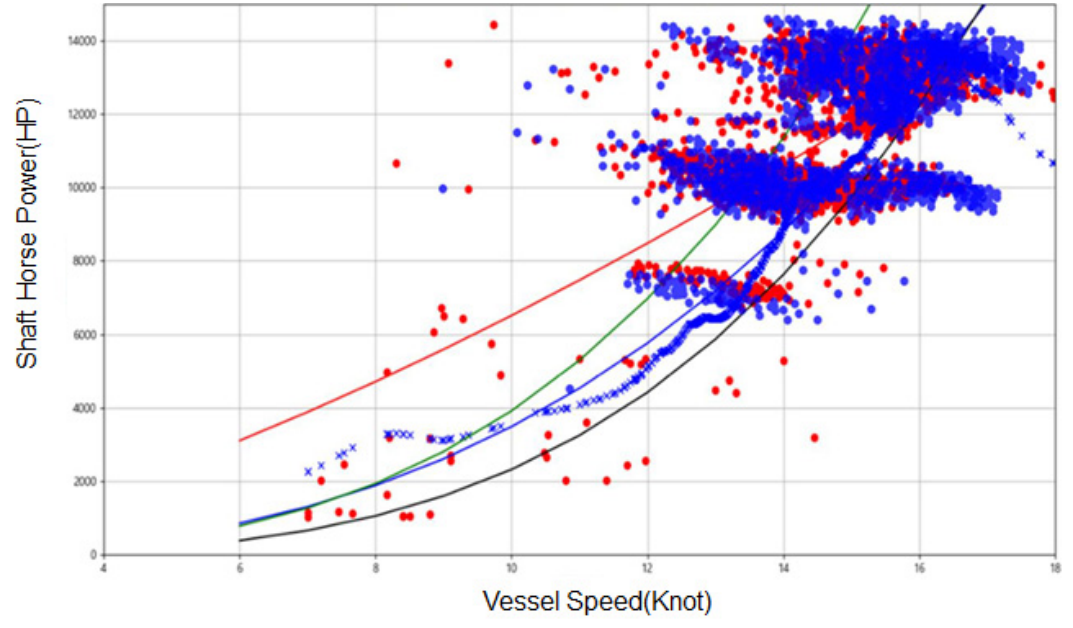
Figure 4. Comparison between predicted propulsion power vs. actual data.